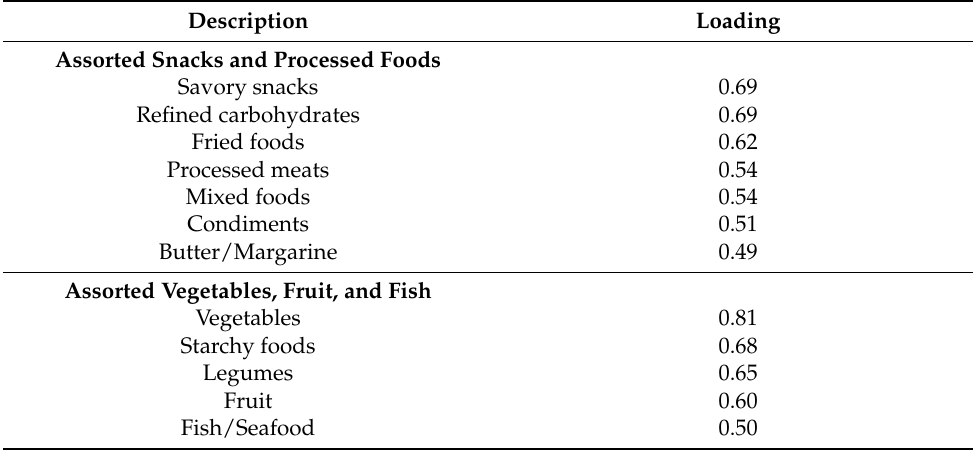
Table 2. Dietary Intake: Principal Component